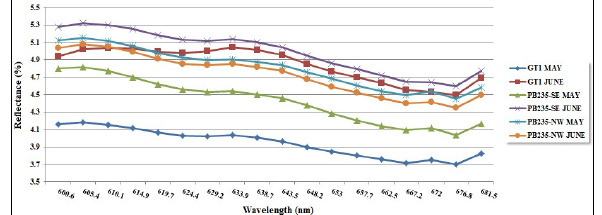
Figure 2. Spectral behaviour in canopy scale from 600 to 700nm, for May and June, of the Rubber trees stands: GT1, PB235-SE and